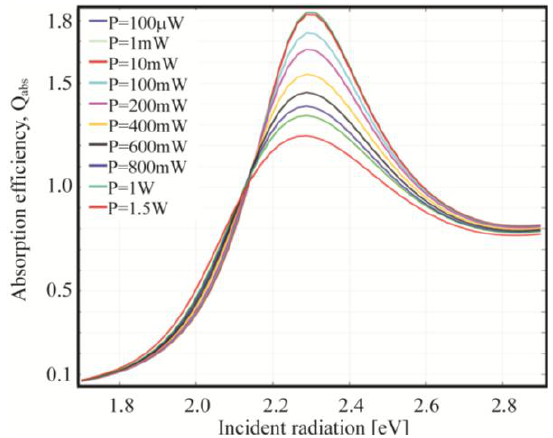
Figure 13. Calculated absorption efficiency spectra for a R = 10 nm gold nanosphere embedded in silica for growing input powers.